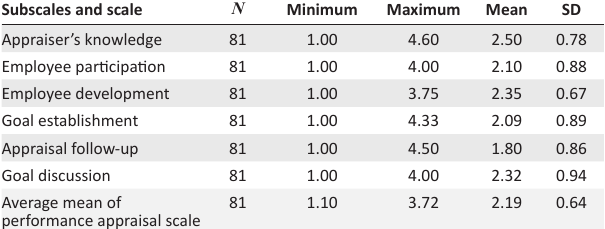
TABLE 4: Means and standard deviations for the six factors and mean score for the performance appraisal scale. Subscales and